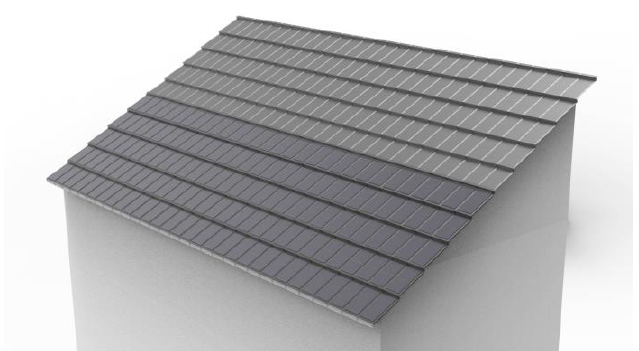
Fig. 9. 1 kWp installation with photovoltaic roof